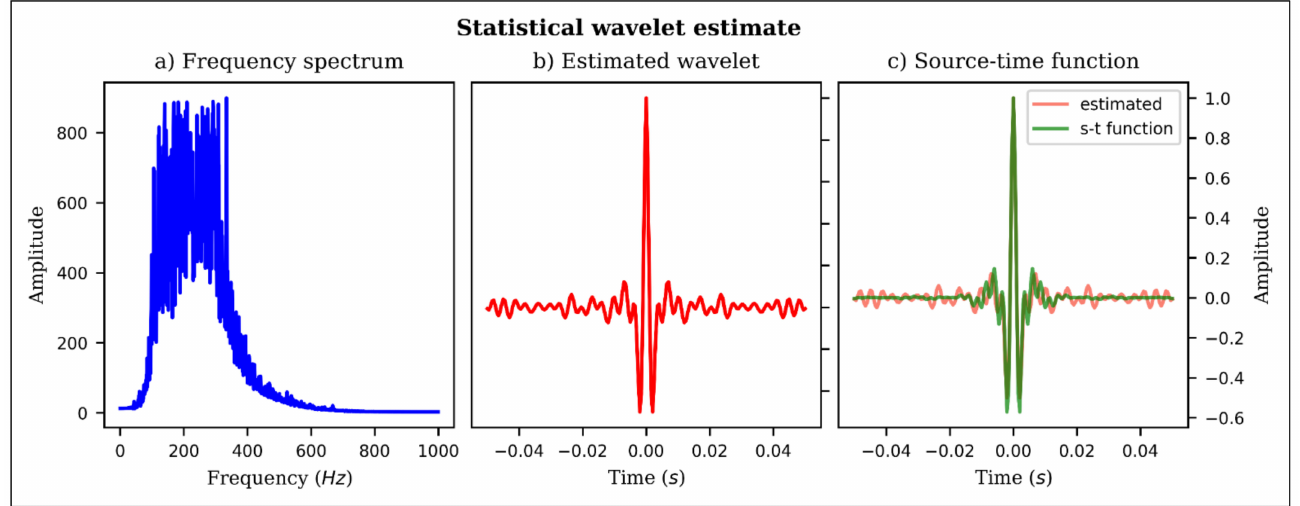
Figure 2. Statistical wavelet estimate from field data, ( a ) mean frequency spectrum of field signal, ( b ) estimated wavelet from field data, ( c ) source time function used in generating synthetic